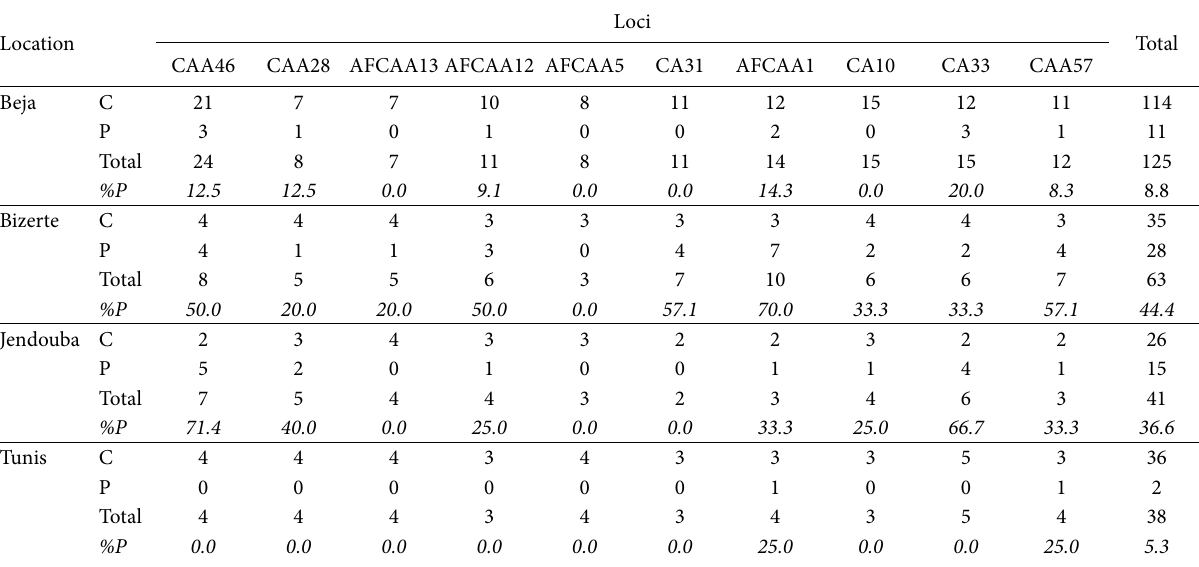
Table 4. Distribution of private (P) and common (C) alleles among populations of Ascochyta fabae sampled in 2012 from four main loca- tions of faba bean production in Tunisia (Beja, Bizerte, Jendouba, Tunis).